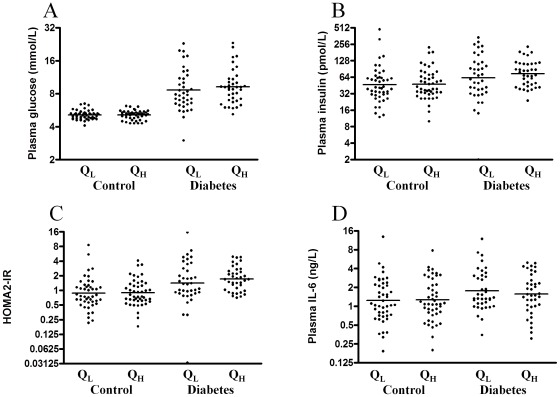
Plasma myostatin divided in low (QL) and high (QH) content in control subjects and patients with type 2 diabetes, respectively.The bar represents geometric means for plasma (A), plasma insulin (B), HOMA2-IR (C) and plasma IL-6 (D). * indicates a difference between low versus high muscle content of myostatin mRNA.